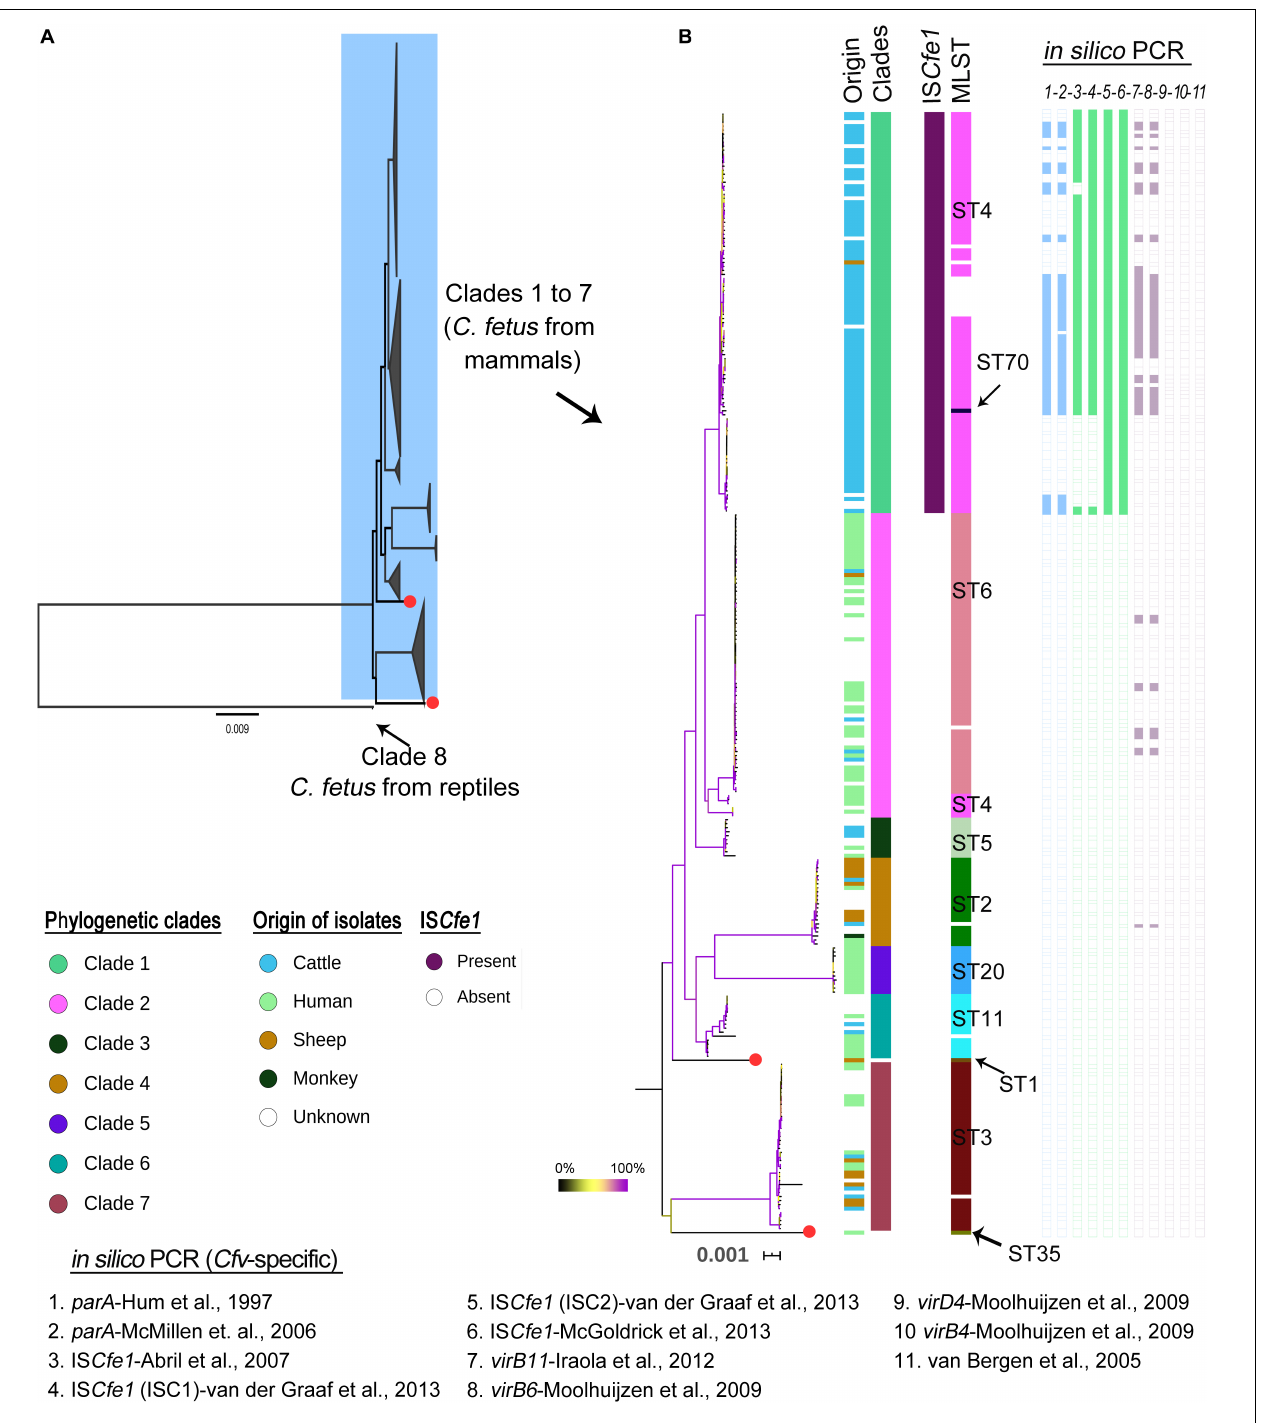
FIGURE 2 | Phylogenetic structure of Campylobacter fetus genomes based on 18,793 high-quality SNPs that were present in a clonal frame in the 281 C. fetus genomes. (A) A maximum likelihood phylogenetic tree with the eight major clades of the species being collapsed. Red colored tips indicate two strains regarded as singletons. Note that clade 8 includes two Campylobacter fetus genomes from reptiles which were divergent to mammalian C. fetus genomes (ANI ∼ 97.8%). (B) A maximum likelihood phylogenetic tree showing clades 1 to 7. The bootstrap values are indicated with branch coloring according to the legend provided in the figure, 0 to 100% bootstrap support corresponds to the branch colors from black to violet, using yellow as the midpoint. Columns beside the phylogenetic tree correspond, respectively, to host of isolation, phylogenetic clades, the presence of IS Cfe1 element, the MLST types, and the results of in silico PCR (numbered one to eleven according to the primer used as in legends). White spaces in the PCR indicate negative results while in MLST, they indicate no assignment to known MLST type.